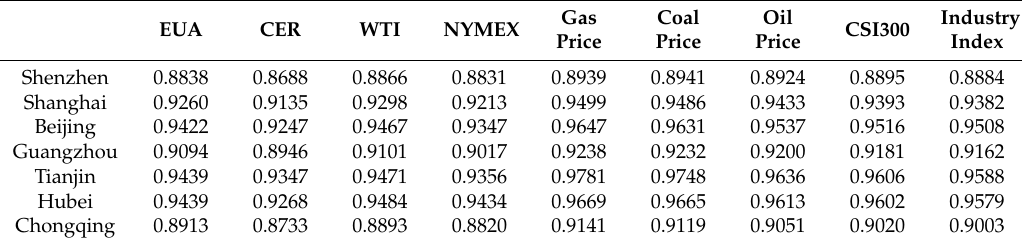
Table 7. Estimated degree of correlation in grey slope relational model.